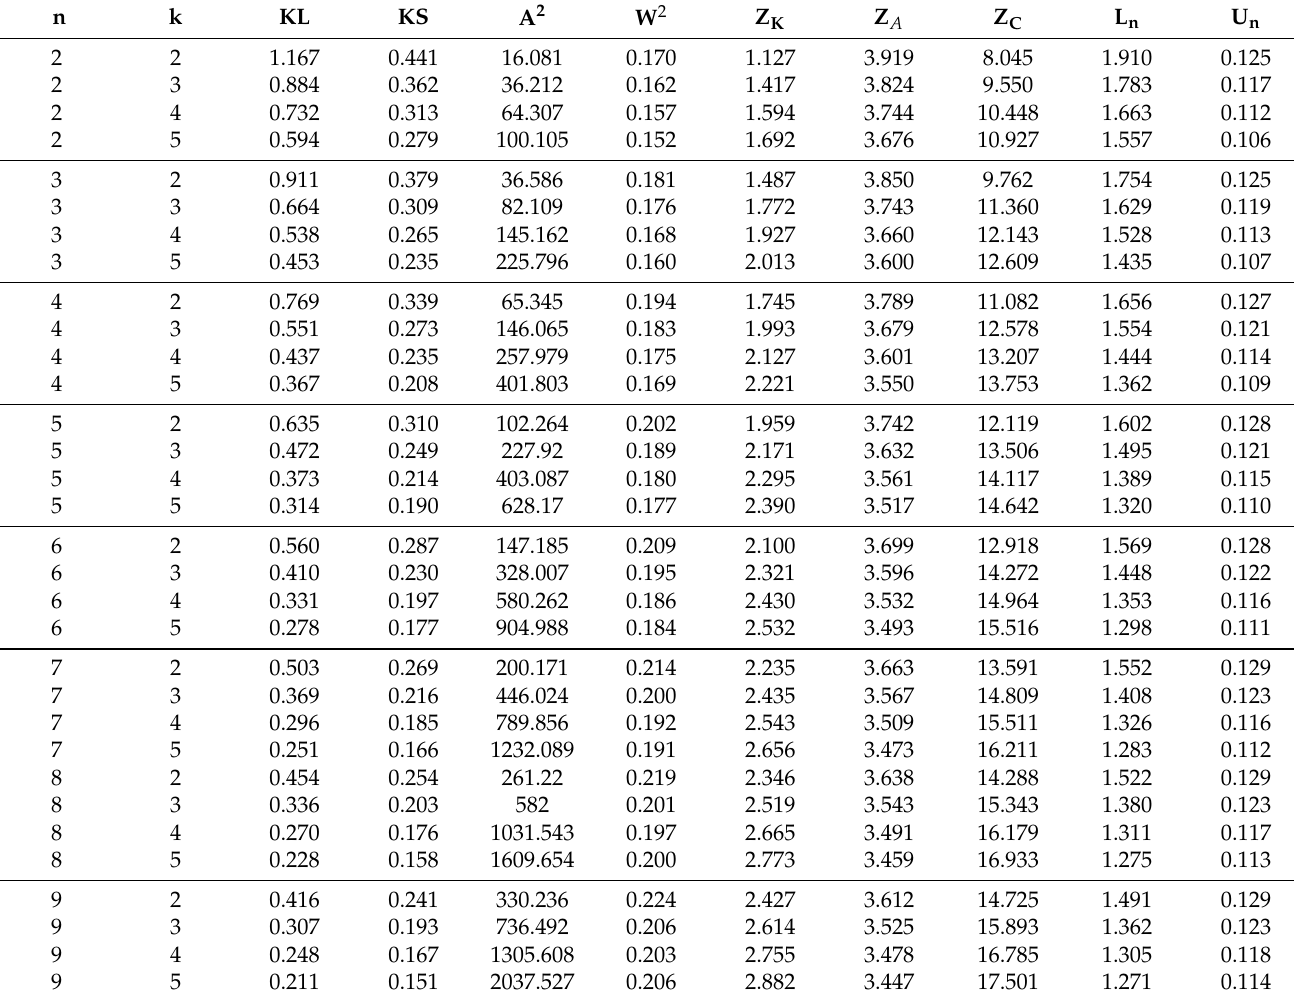
Table 3. The CV values of different tests of WGQLD for some values of ( n , k ) in RSS, at significance level of γ =